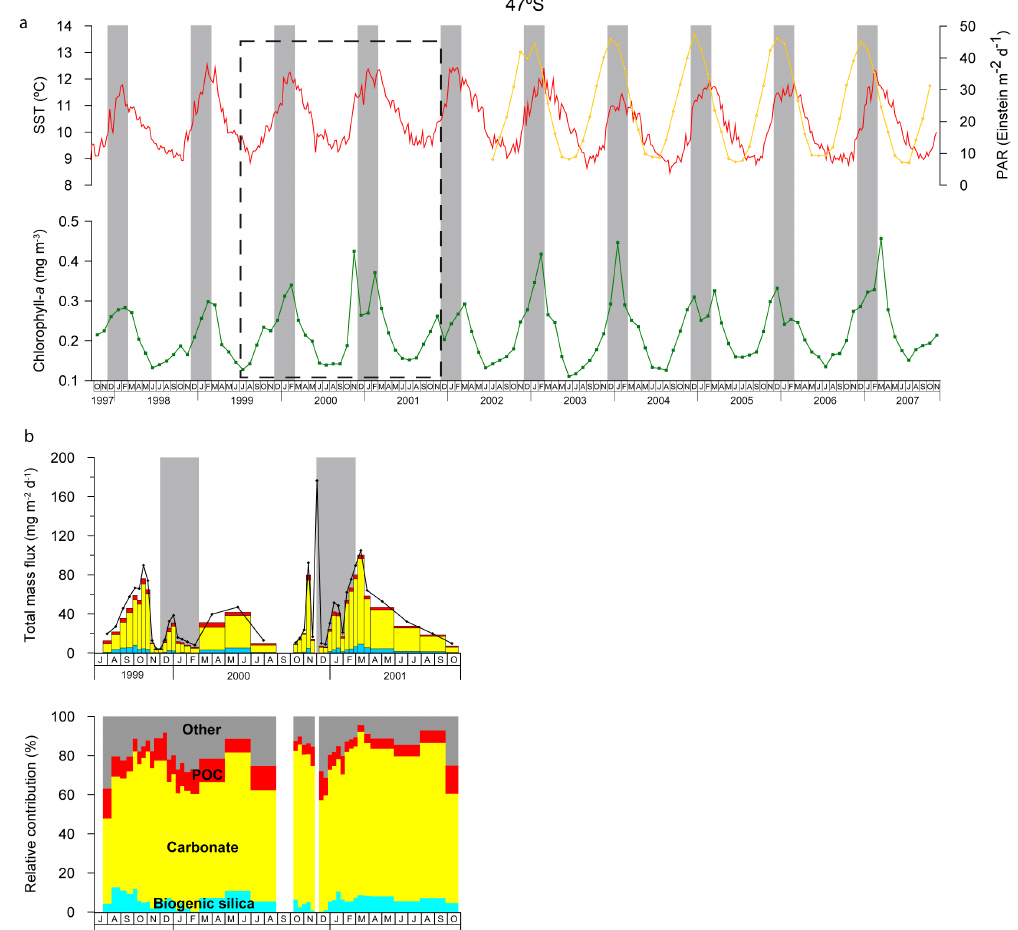
Figure 2. (a) Available mean sea surface temperature (SST), photosynthetically available radiation (PAR) and chlorophyll a concentration for the 47 ◦ S site. The dashed intervals represent the studied periods. (b) Temporal variability of the total and major component fluxes, and their relative contributions to the total mass flux for the <1mm fraction at 1000m water depth at the 47 ◦ S site for the period July 1999– October 2001. Biogenic silica, carbonate and particulate organic carbon (POC) were directly measured. “Other” indicates un-characterized mass contributions (organic components other than carbon and small amounts of lithogenic material; Trull et al., 2001). Grey horizontal bars highlight the summer period (December to February) of each